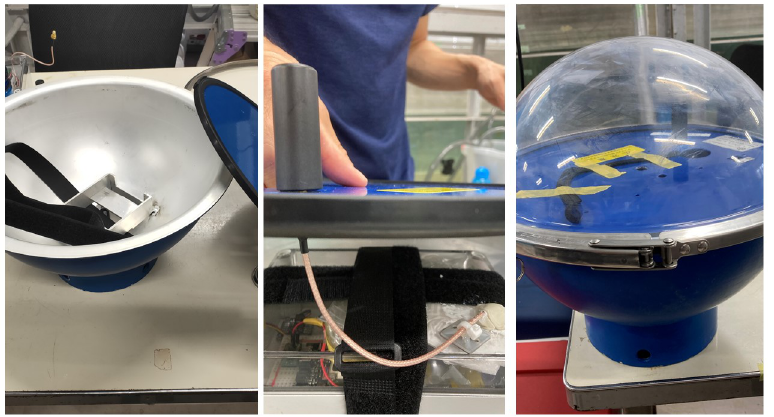
Figure A2. Illustrations of Zeni Lite drifting buoy being used as a floating housing. The left image shows the bottom part of the buoy where the Takachi box was fixed. The middle image shows how the antenna was attached through the blue plate. The right image shows the assembled